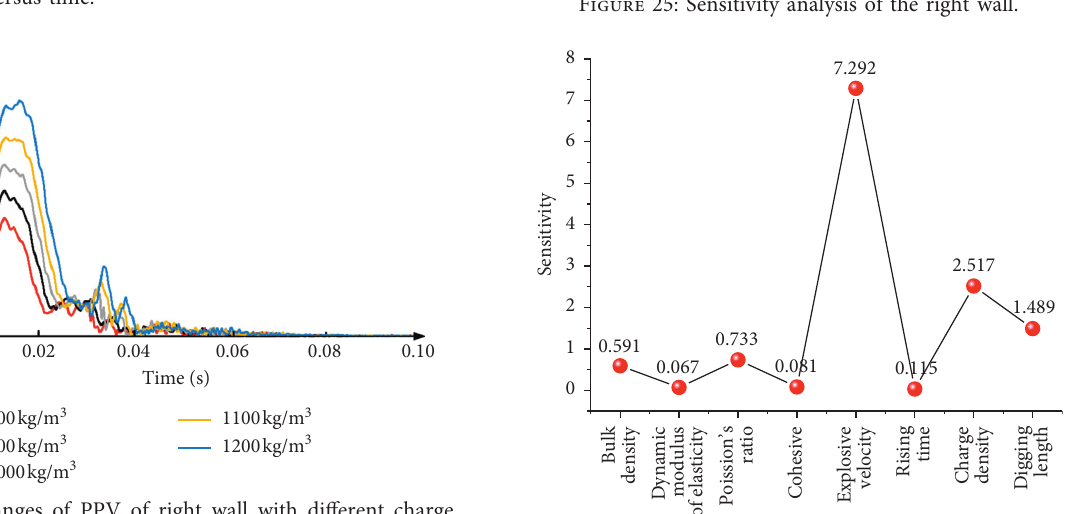
Figure 22: Changes of PPV of right wall with different rising pressure time versus time.